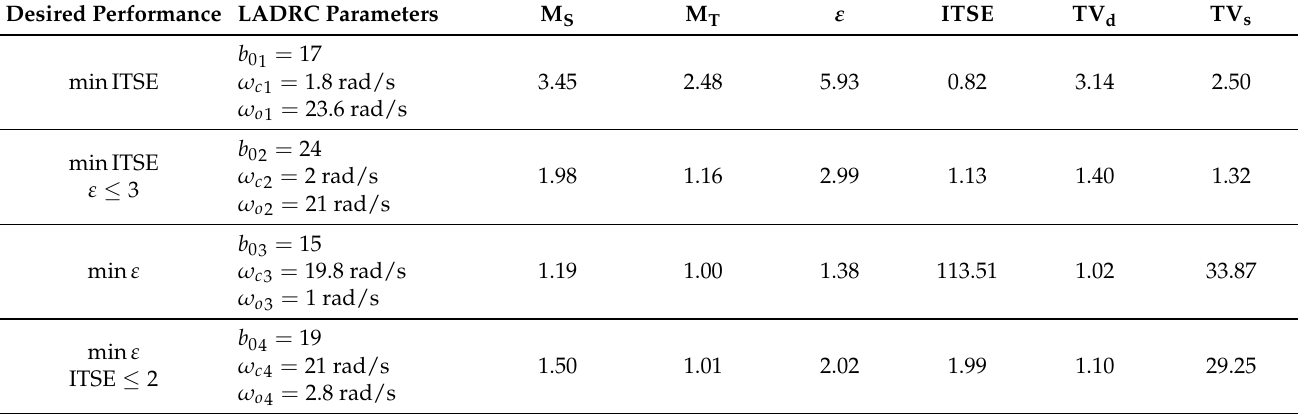
Table 2. Comparison of LADRC performance in control of G e ( s )